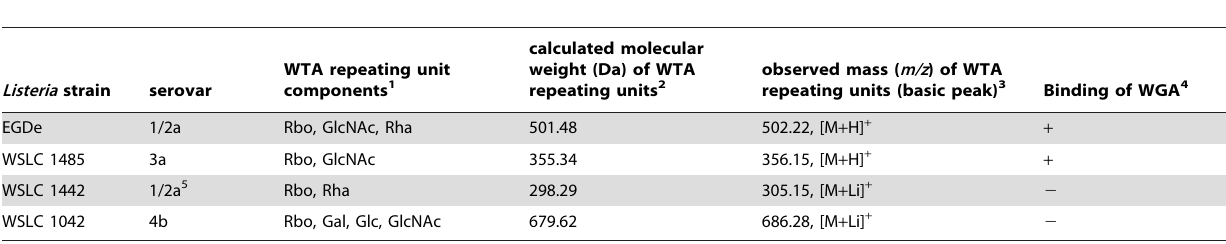
Table 1. Mass spectrometry data, carbohydrate composition of the WTA repeating units, and WGA binding properties for the bacterial strains used in this study.